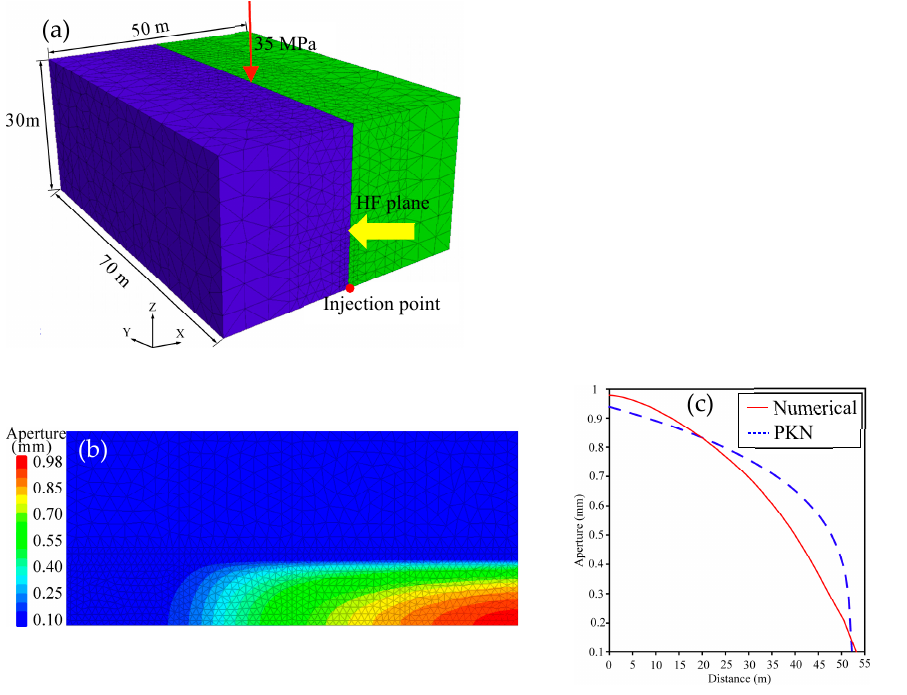
Figure 4. ( a ) The validation model; ( b ) fracture aperture distributions calculated by the numerical and PKN solutions; ( c ) fracture comparison between the fracture apertures calculated by the numerical and PKN solutions.